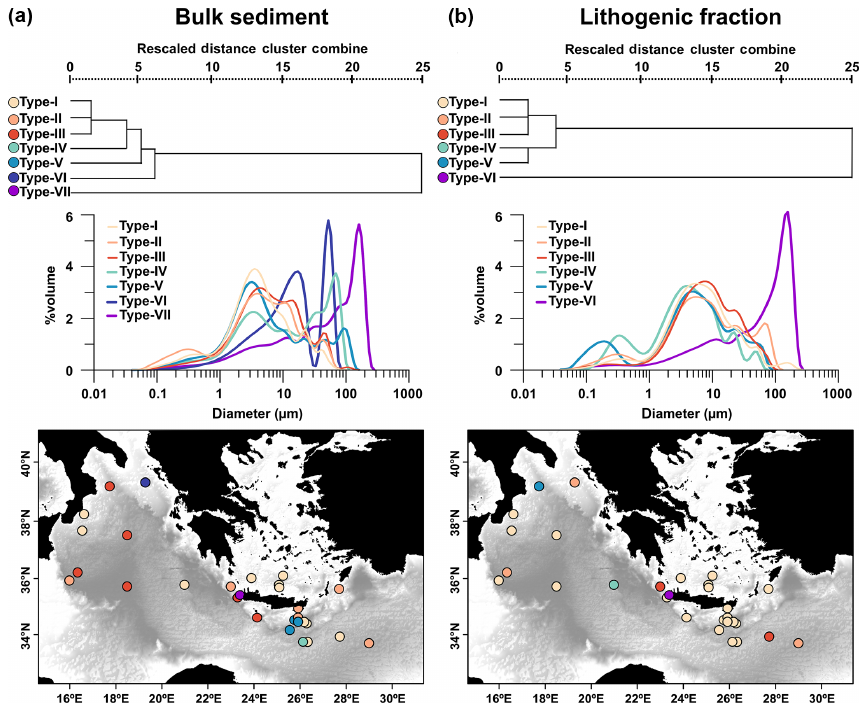
Figure 2. Statistical dendrogram of type-averaged grain size profiles and geographical distribution of grain size compositional types for (a) the lithogenic fraction and (b) the bulk fraction of the investigated